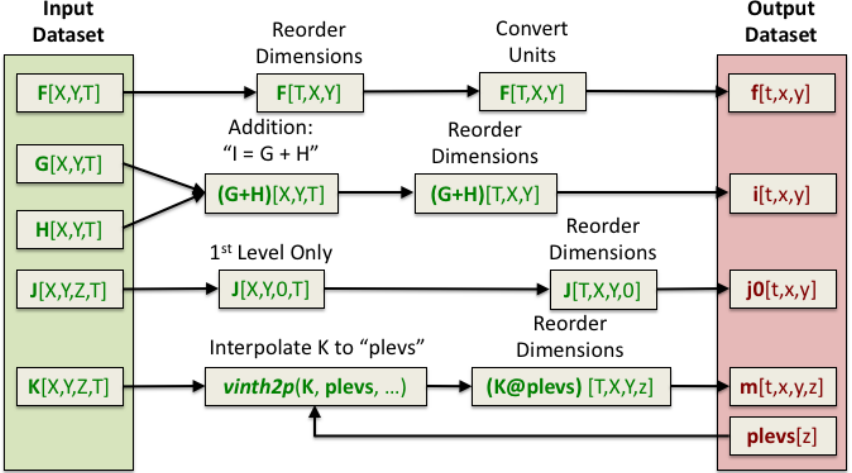
Figure 7. An example of a PyConform job. Each MPI rank is responsible for creating a particular output dataset. Its job is to retrieve the variable data it needs, map operations, execute these operations, and then write the